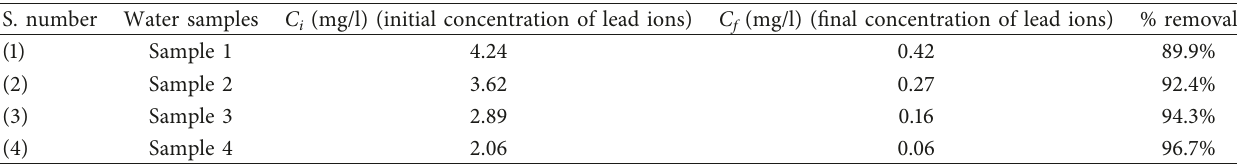
Table 5: Lead concentration (before and after) of samples (samples collected from the effluents of lead-based industries in Andhra Pradesh, India). S.